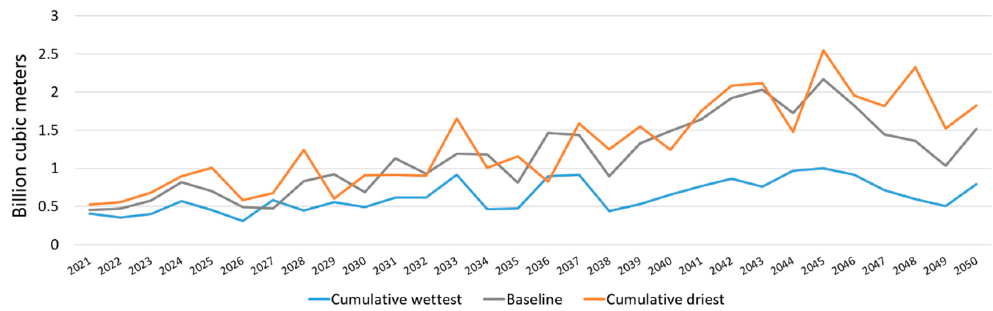
Figure 10. Irrigation water requirements in the analyzed scenarios (billion cubic meters).